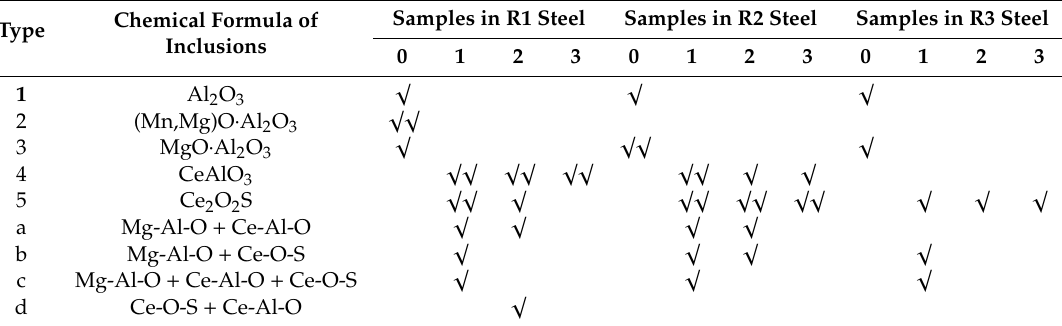
Table 3. Types of inclusions at different stages.